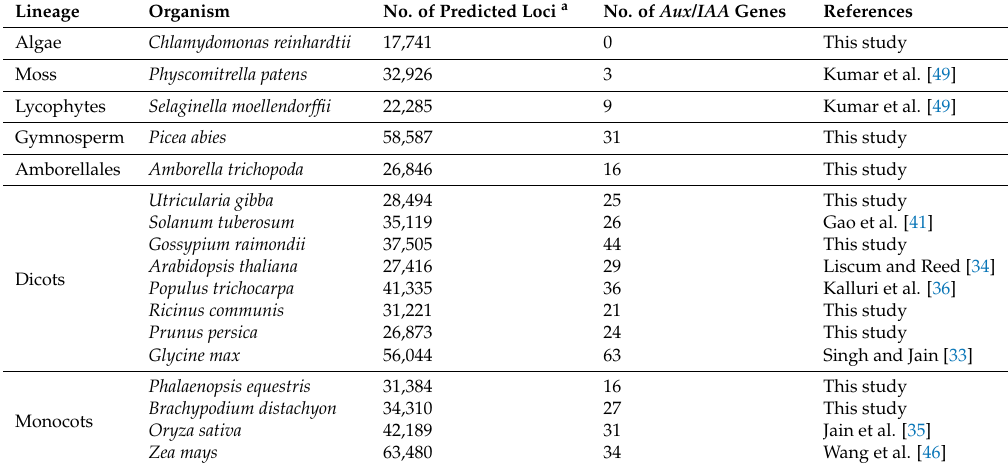
Table 1. Aux/IAA genes identified from 17 sequenced plant